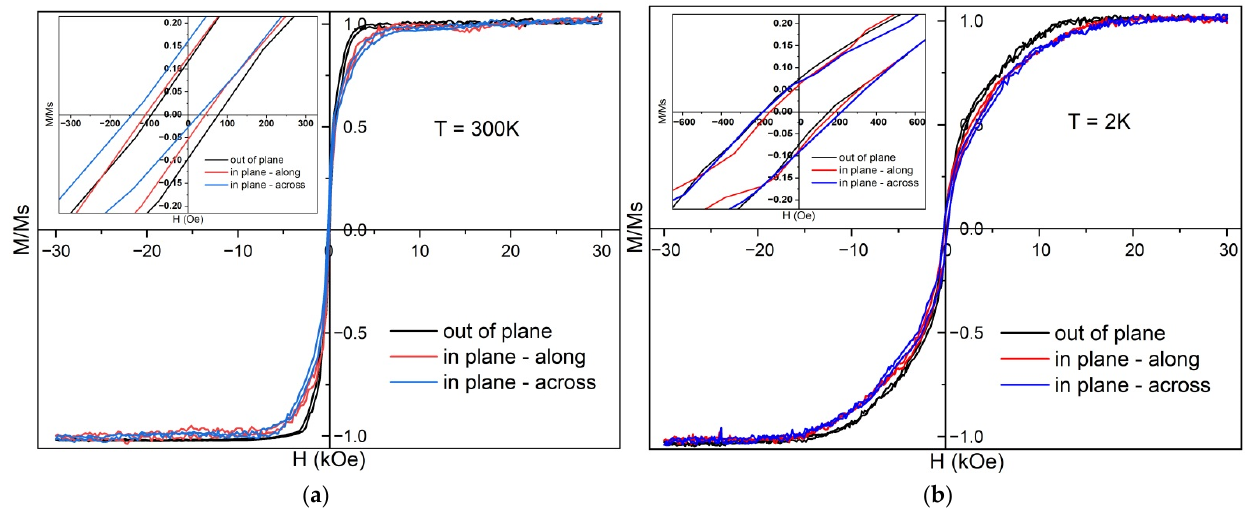
Figure 3. Magnetization reversal loops of the α -FeSi 2 NRs array on Si(111)-4° at 300 K ( a ) and 2 K ( b ) for three directions of the magnetic field (“out of plane”; “in plane—along”; “in plane—across”). The insets show the area of small fields.